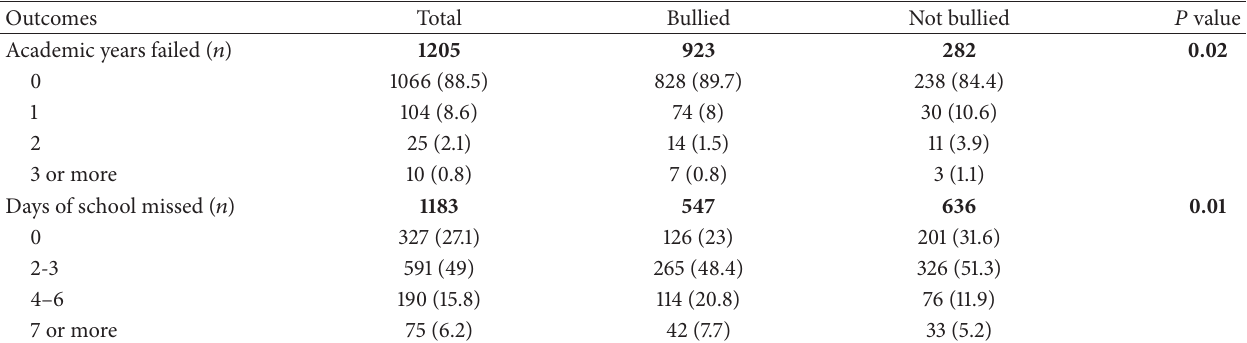
Table 4: Comparison between bullied and nonbullied pupils for academic years failed and days of school missed, Oman, 2007. Outcomes Total